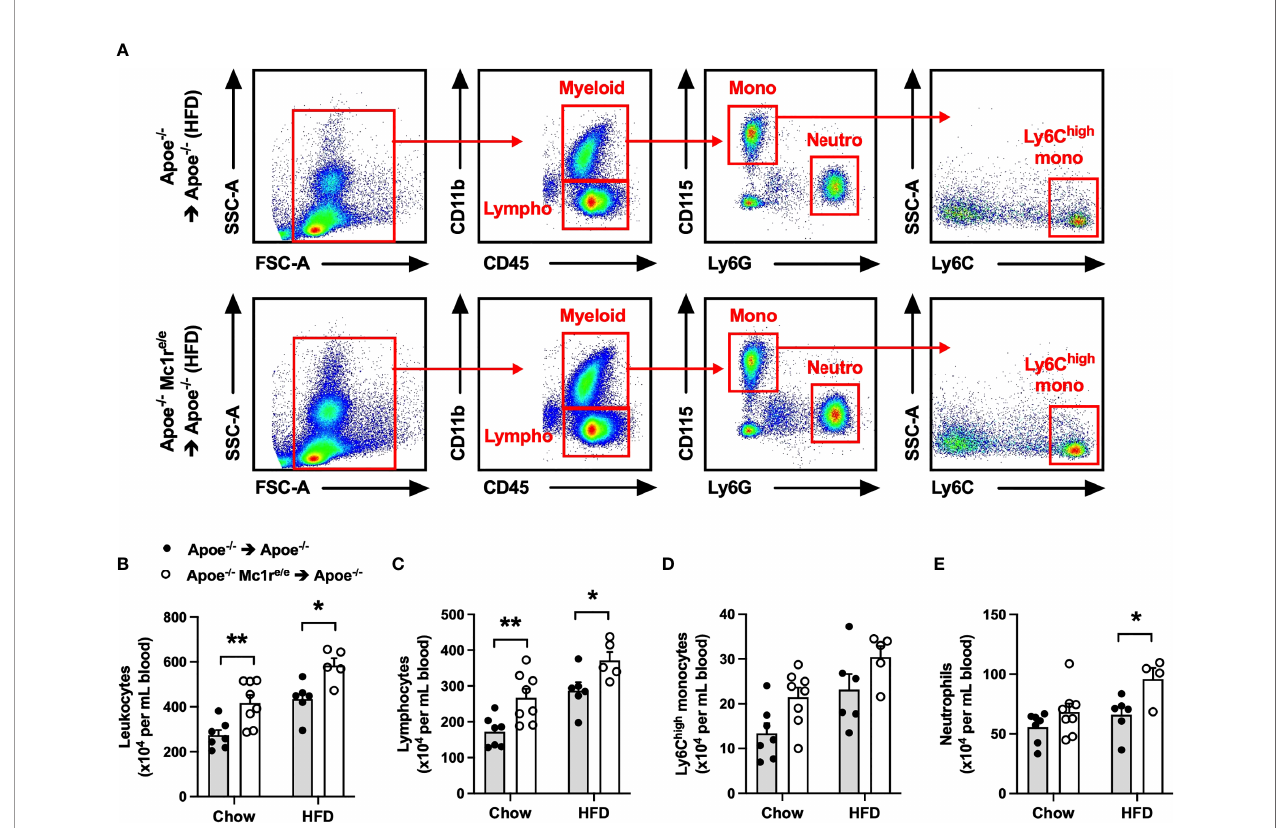
FIGURE 1 | Hematopoietic MC1-R de fi ciency induced leukocytosis in Apoe -/- mice. (A) Representative dot plots for the gating of total leukocytes (CD45 + ), lymphocytes (CD45 + , CD11b - ), neutrophils (CD45 + , CD11b + , CD115 - Ly6G + ) and Ly6C high monocytes (CD45 + , CD11b + , CD115 + , Ly6C high ) in the peripheral blood of Apoe -/- and Apoe -/- Mc1r e/e BM transplanted mice. (B – E) Quanti fi cation of total leukocyte, lymphocyte, Ly6C high monocyte and neutrophil counts in the blood of Apoe -/- and Apoe -/- Mc1r e/e BM transplanted mice fed a chow or high-fat diet (HFD) for 10 weeks. Data are mean ± SEM, *P < 0.05, **P < 0.01 versus Apoe -/- mice. Each dot represents individual mouse. SSC-A indicates side scatter area; FSC-A, forward scatter area; Apoe, apolipoprotein